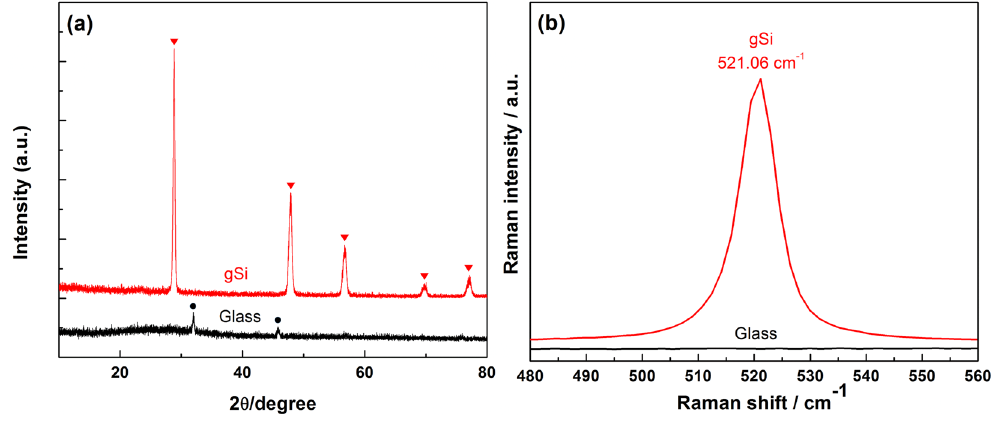
Figure 2. ( a ) XRD patterns and ( b ) Raman spectra of pre-reduction milled glass powder and post-reduction gSi.